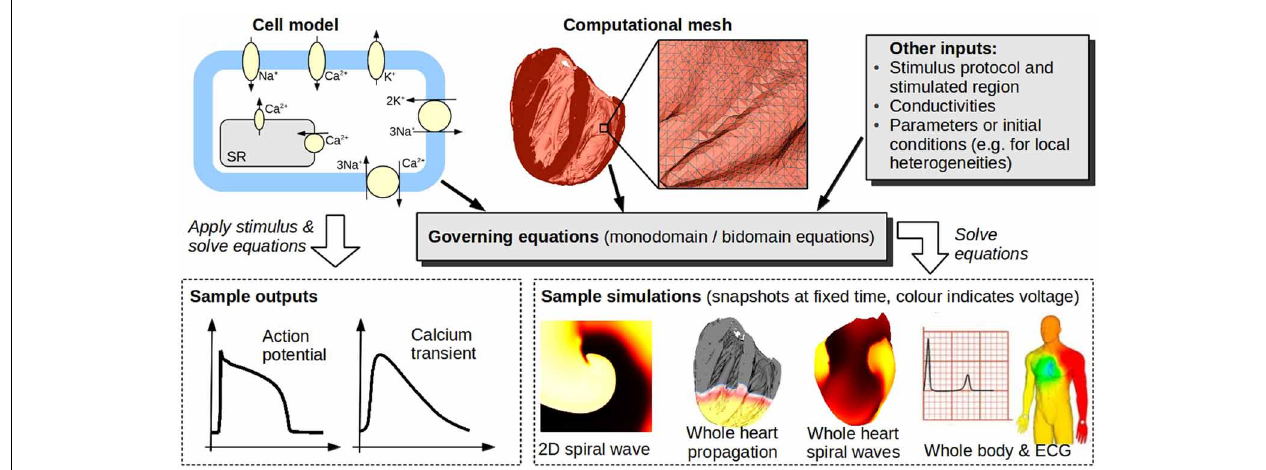
FIGURE 1 | Cardiac models. Models of isolated cardiac cells (typically systems of ordinary differential equations) are known as cell models. Top left schematic illustrates channels, pumps, and exchangers modeled in a (relatively simple) cell model. Cell models can be used to predict quantities such as action potential, or they may be coupled to partial differential equations governing spatial propagation [usually the so-called monodomain or bidomain equations, see Keener and Sneyd (1998)],